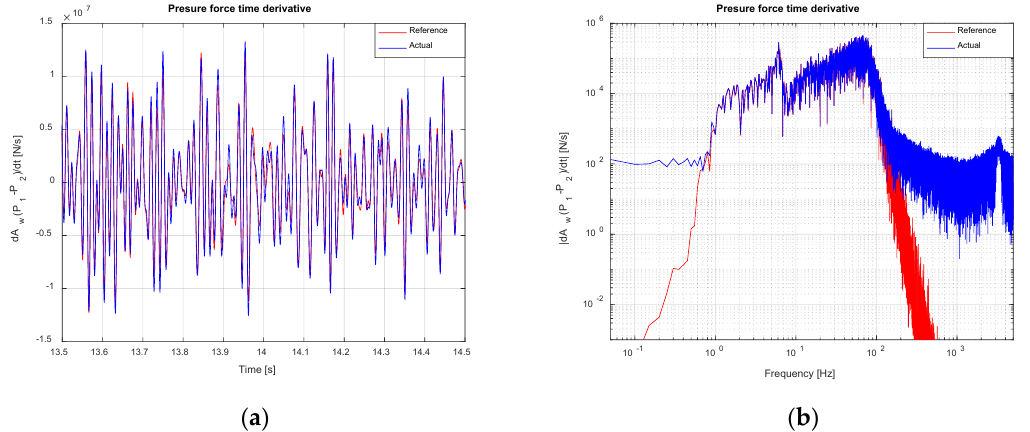
Figure 22. Pressure force time derivative tracking (noise-contaminated scenario). TVC Enabled: ( a ) Time domain; ( b ) Frequency domain.